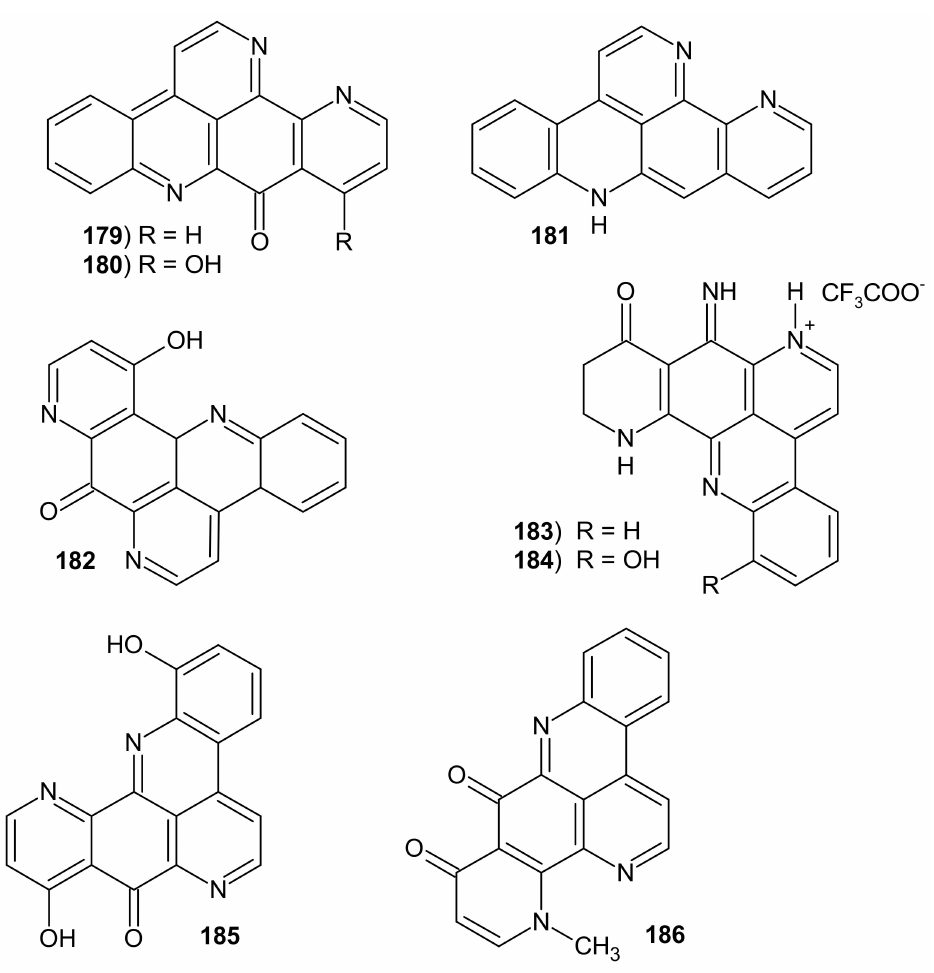
Figure 44. Structures of ascididemin analogs 179 – 186